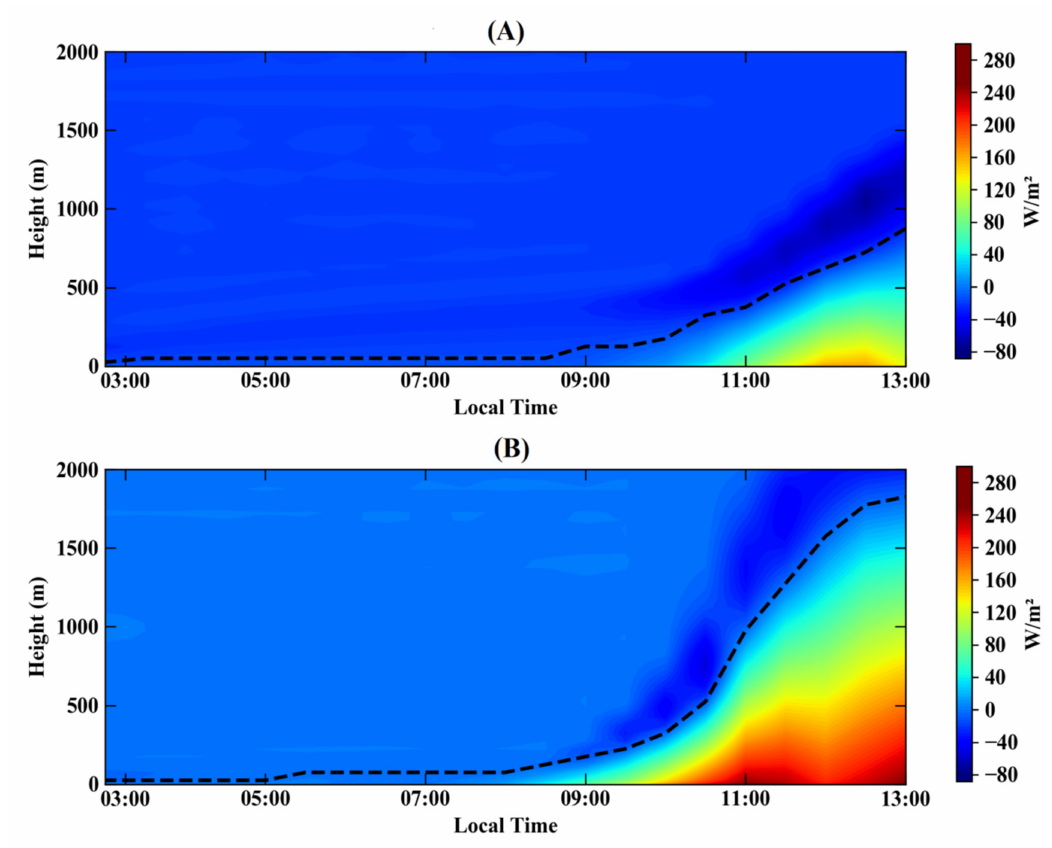
Figure 6. Time series of the vertical profiles of the horizontally averaged sensible heat flux ( w (cid:48) θ (cid:48) ) simulated by the PALM model over the GoAmazon site for ( A ) IOP 3 and ( B ) IOP 4. The dashed line represents the height where the flux is zero ( w (cid:48) θ (cid:48) =